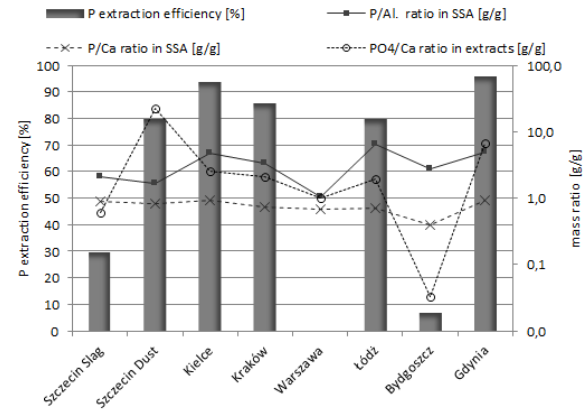
Figure 3: Comparison of P extraction efficiency with main components ratio in SSA and obtained